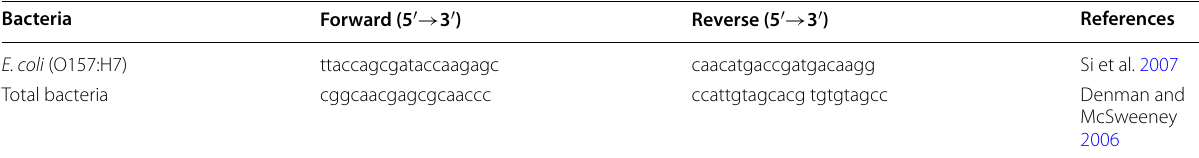
Table 8 The list of the primers used for ileum microbial population analysis